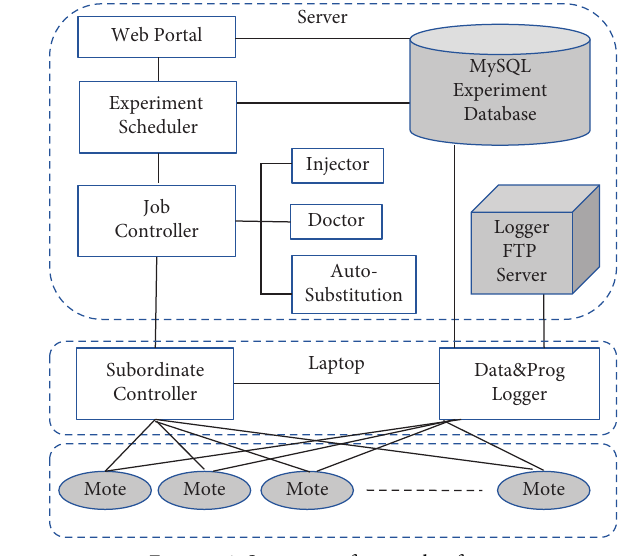
Figure 6: Structure of control